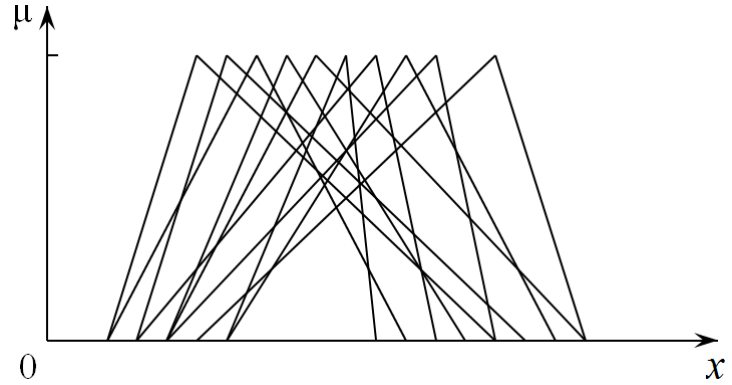
Figure 1. Different membership functions for some eye contact perceived by different people